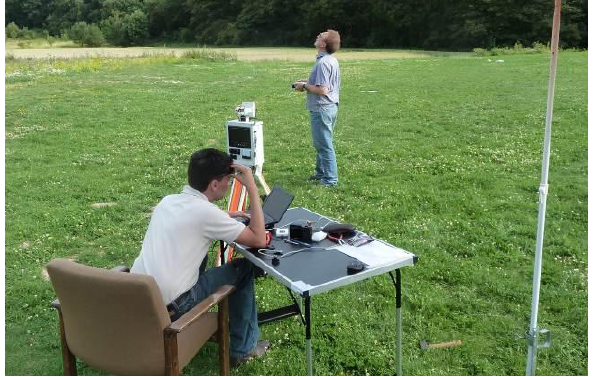
Figure 8. Ground control with tracking antenna Over all some positions failed, which means no image had been taken or taken too late (manually). The quality of positioning varies with a mean deviation from 3 – 4 m, not considering some outlier of more than 10 m.